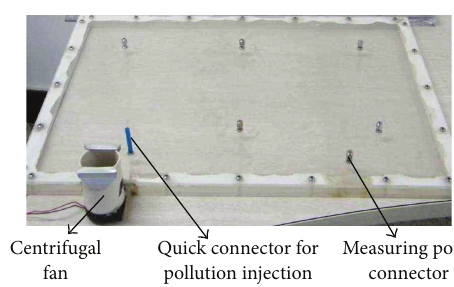
= 0.3 m/s, 𝑆 = 0.25 kg/m 2 ⋅ s, and Φ = 9.34 %). in